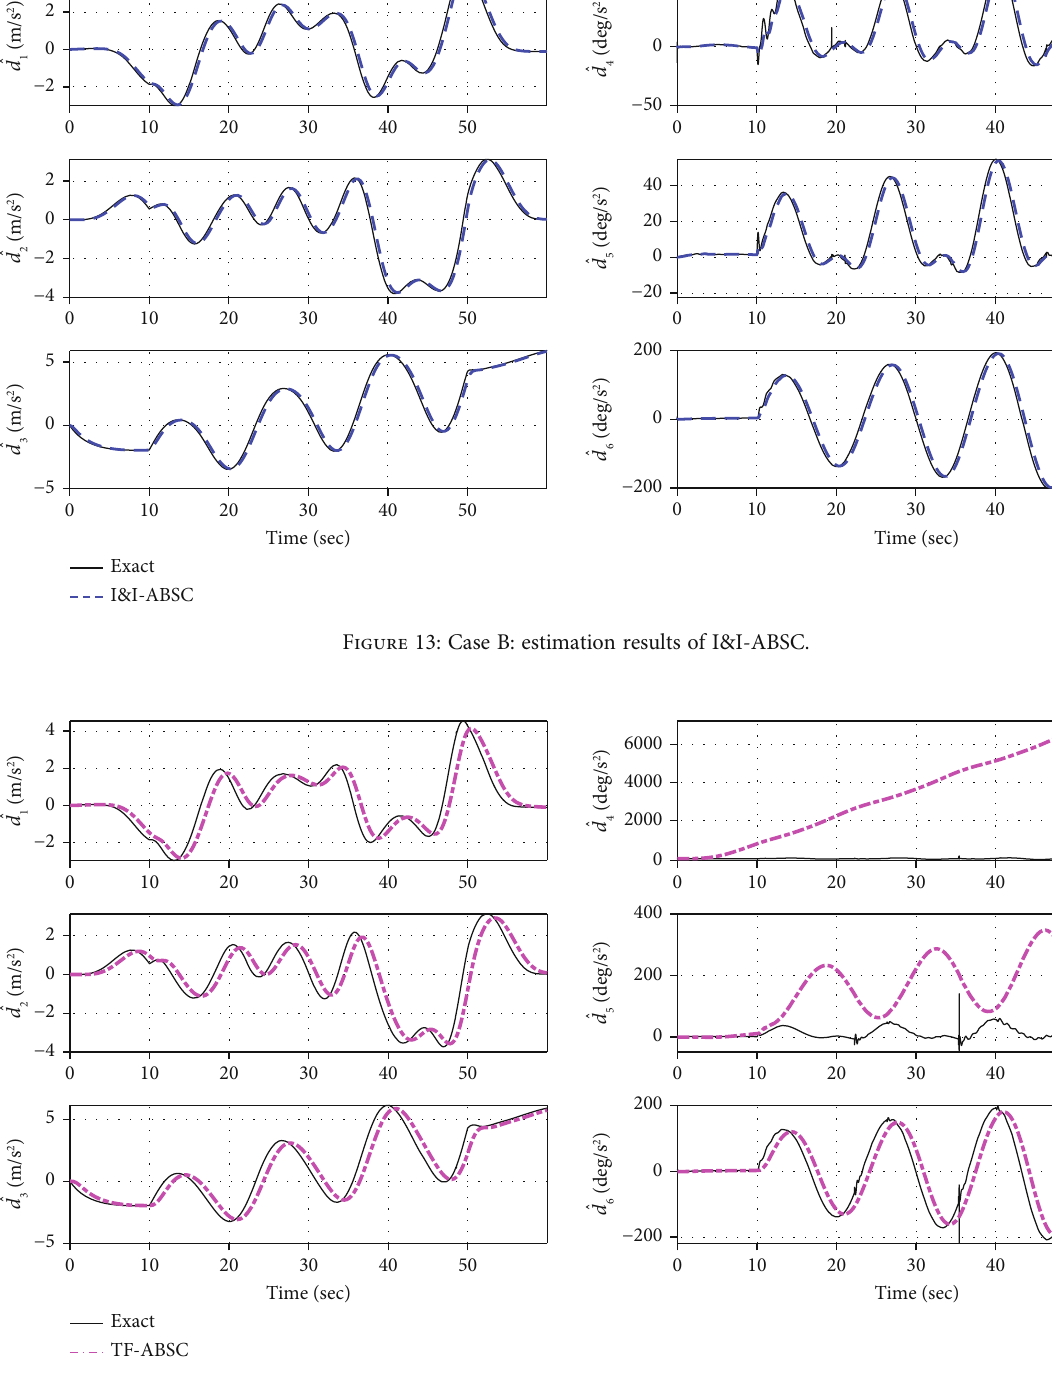
Figure 14: Case B: estimation results of